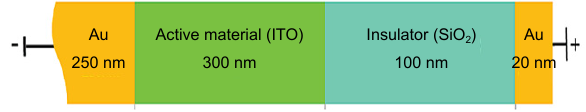
Fig. 2 | The metal-oxide-semiconductor heterostructure with ITO as the active material . Figure reproduced from ref. 119 , American Chemical